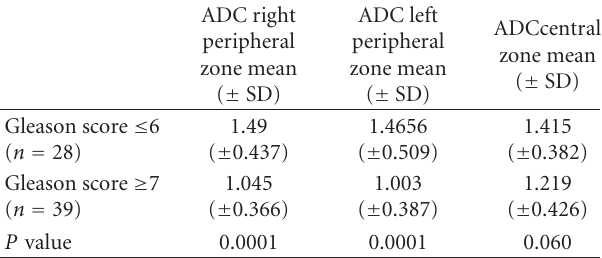
and 86.4%, with specificity range between 50.8–63.2%.